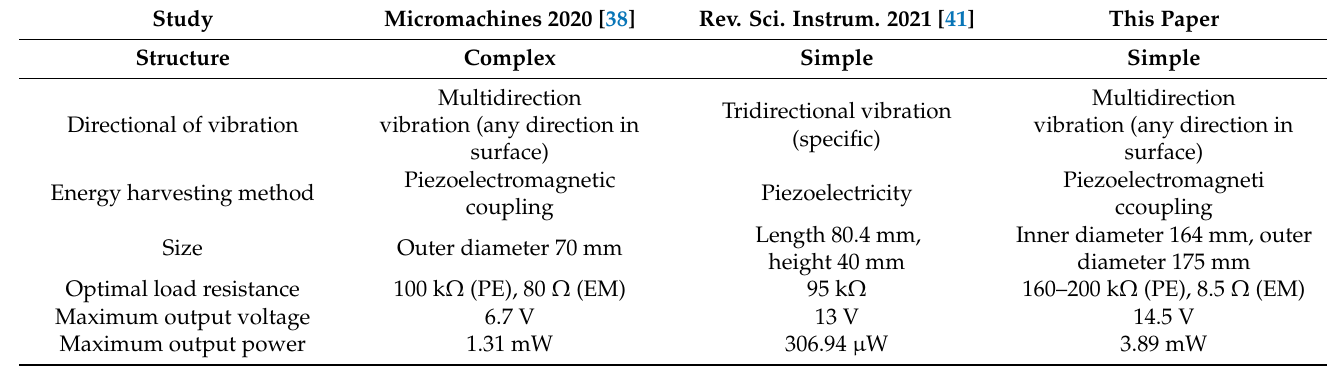
Table 3. Comparison of several multidirection energy